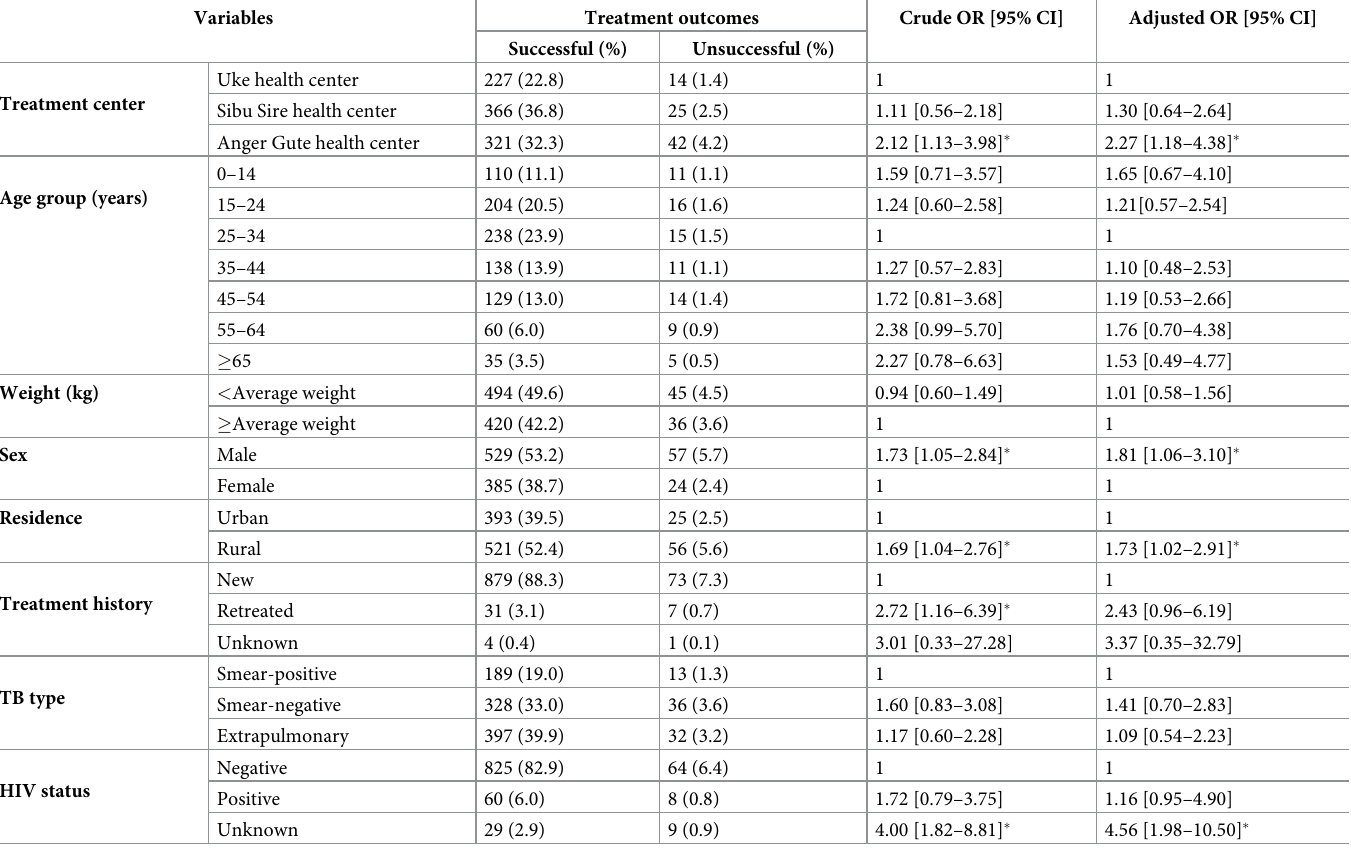
Table 3. Socio-demographic and clinical variables associated with unsuccessful treatment outcome at three TB treatment centers in East Wollega from 2012 to 2016.